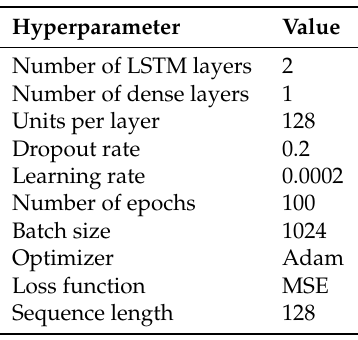
Table 3. Network hyperparameters.